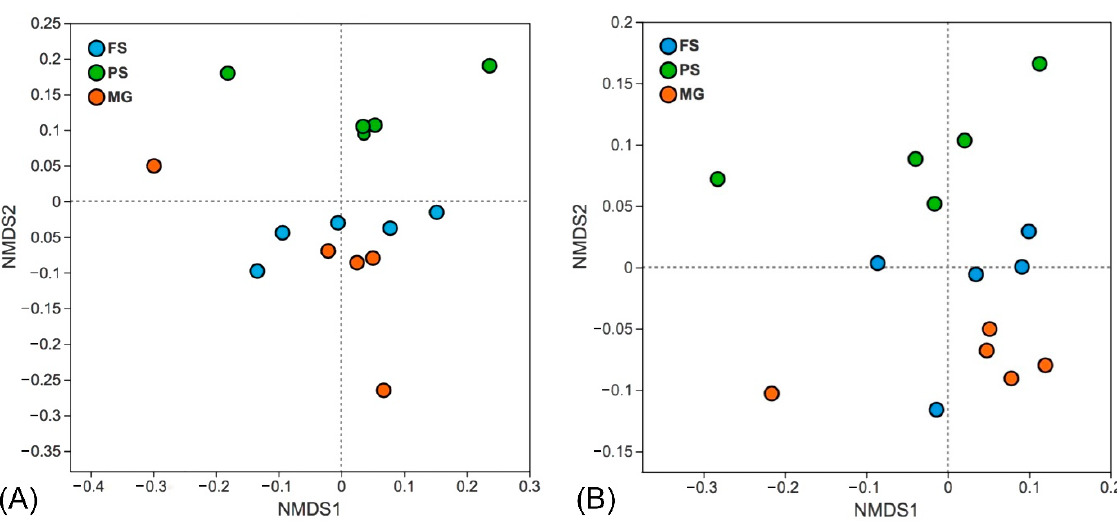
Figure 4. Nonmetric multidimensional scaling ordination of prokaryotic samples extracted by the FS, PS and MG kits based on Bray–Curtis distances ( A ) and unweighted UniFrac phylogenetic dis- tances ( B ).